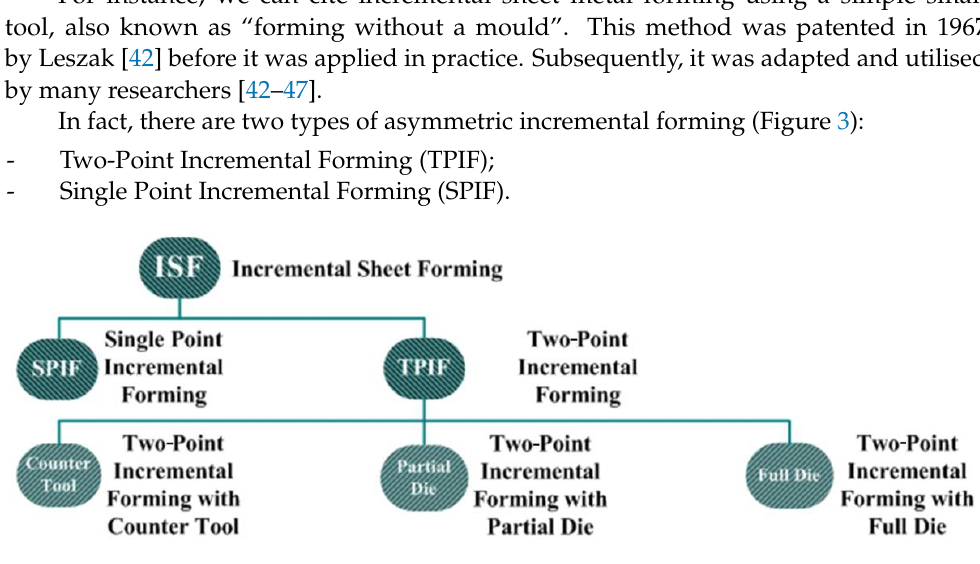
Figure 3. Methods based on the ISF Process.